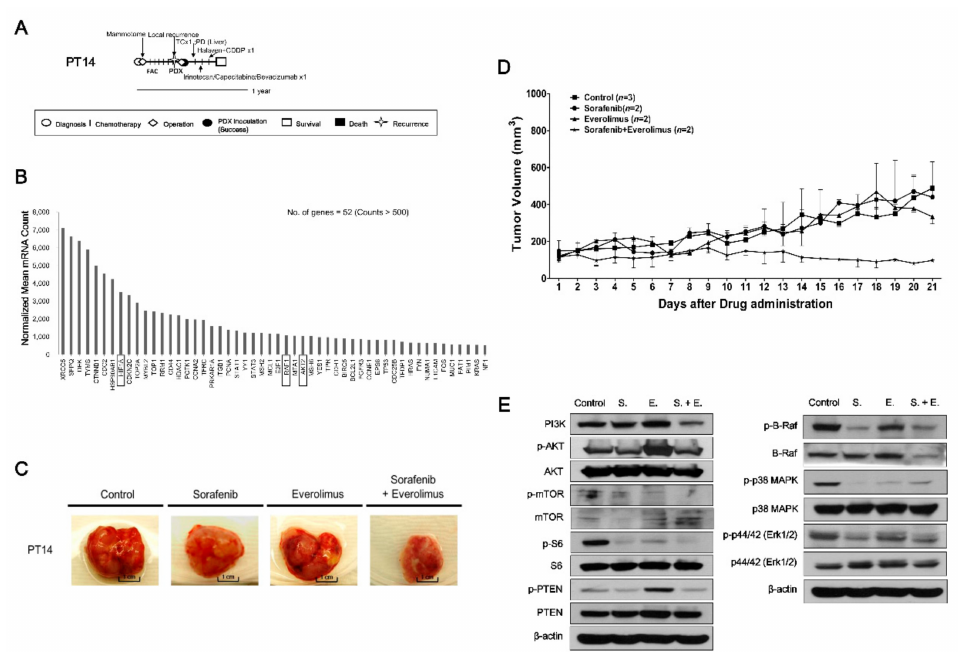
Figure 2. In vivo e ffi cacy of sorafenib and everolimus against PDX models from PT14 (TNBC subtype). ( A ) PT14 treatment history. See text for details. Scale bar, one year. ( B ) Gene expression analysis using Nanostring nCounter GX human cancer reference kit in the PDX model (F1) from PT14. Expression data were analyzed using the nSolver analysis module. Expression values (nCounts) were normalized to six internal reference genes. The top upregulated 52 genes with counts > 500 were selected among the 230 human cancer-related genes. ( C ) Images of PDX model tumors from PT14 following treatment with sorafenib and everolimus, alone and in combination. ( D ) Tumor volumes (F3) were determined in female mice ( n = 2–3) treated with sorafenib ( (cid:8) , 120 mg / kg), everolimus ( (cid:78) , 20 mg / kg), or their combination ( (cid:70) ), administered once daily for three weeks by oral gavage; mice administered saline ( (cid:4) ) served as controls. Tumor volumes at 21 days are presented as means ± SD ( p < 0.05 for control vs. sorafenib + everolimus; unpaired t -test). ( E ) Expression of PI3K, p-AKT, AKT, p-mTOR, mTOR, p-S6, S6, p-PTEN, PTEN, p-B-Raf, B-Raf, p-p38 MAPK, p38 MAPK, p-p44 / 42, p44 / 42, and β -actin proteins in PDX tumors from PT14 treated with sorafenib, everolimus, and their combination. S.; sorafenib, E.; everolimus, S. + E.; sorafenib +